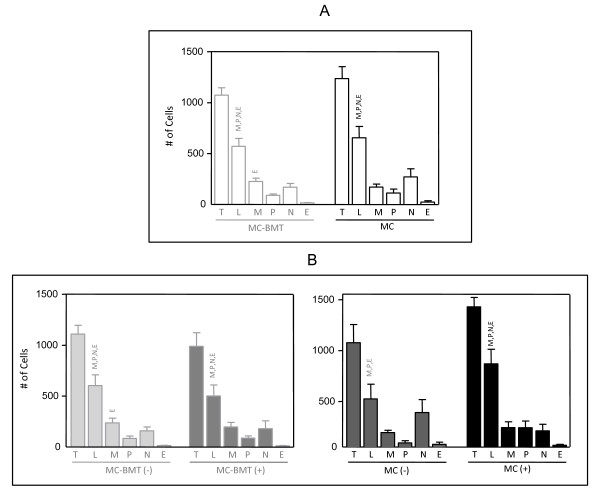
Composition of inflammatory infiltrate associated with canine mammary carcinoma. Infiltrating leukocyte populations from MC-BMT or MC (A), further subcategorized according to the absence (-) or presence (+) of lymph node metastasis (-) (B). The inflammatory cells were characterized by image analysis as described in Material and Methods. Data were expressed as number of cells (#) per eight "Hot Spots" histological fields. Significant differences at p < 0.05 are highlighted by asterisk.